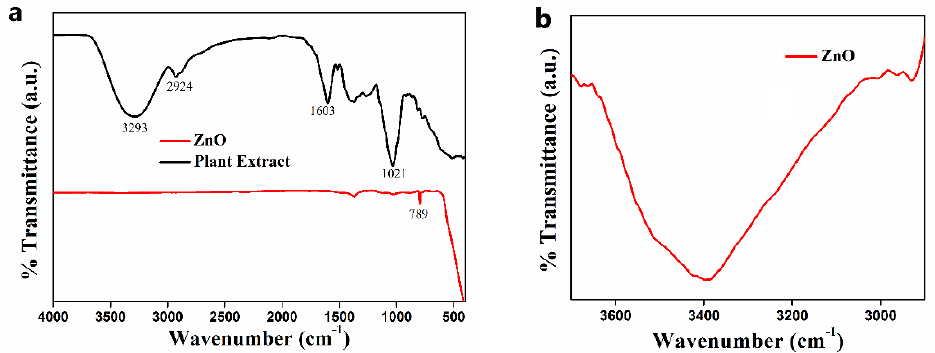
Figure 2. ( a ) FT-IR spectra of leaf extract and ZnO NPs; ( b ) The expanded region of FT-IR spectra around 3100 to 3500 cm − 1 of the ZnO sample.